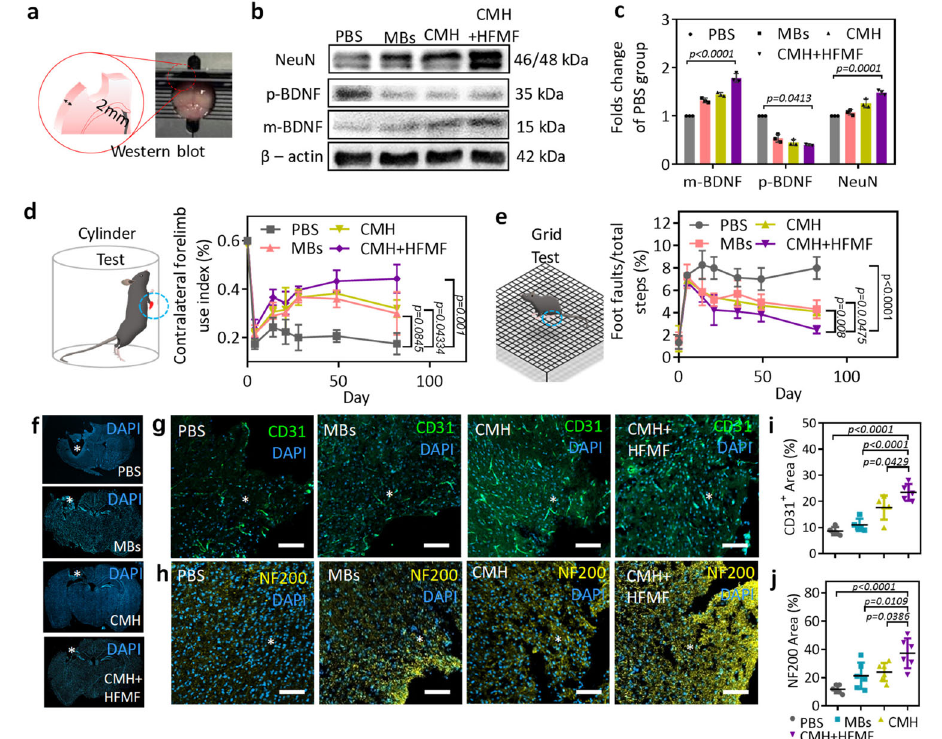
Fig. 8 | Western blot analysis and post-TBI neurological recovery and axonal sprouting. a Tissue slice of trauma area of ipsilateral brain slice with 2mm. b Western blot analysis of brain. β -actin was selected as the internal control with a protein weight of 42kDa; the values of m-BDNF and p-BDNF were 15 and 35kDa, respectively. NeuN was 46 and 48 KDa, respectively. c The quantitative results of proteinsareexpressedastheratioofdensitometriesofm-BDNF,p-BDNFandNeuN to β -actin bands. Error bars represent mean ± s.d., n = 6, one-way ANOVA with a tralateral forelimb. Error bars represent mean ± s.d., n =6, one-way ANOVA with a